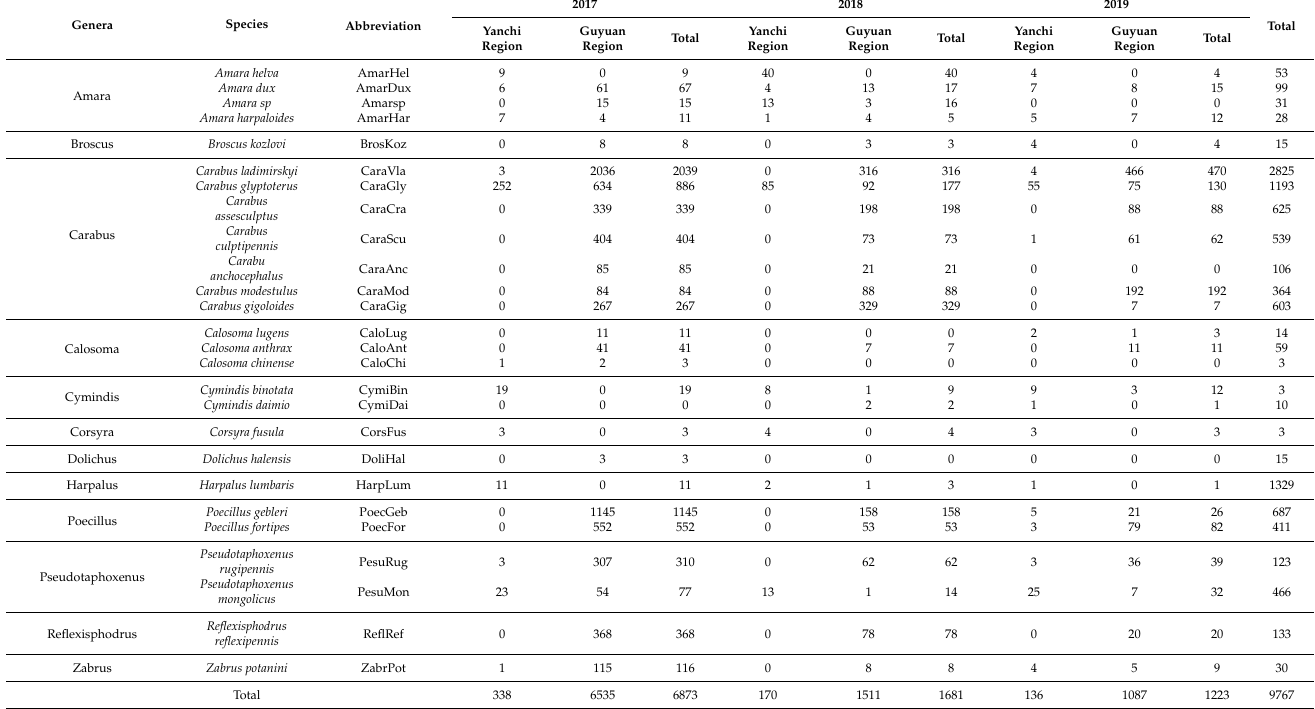
Table A1. Species and individuals of Carabidae in different region